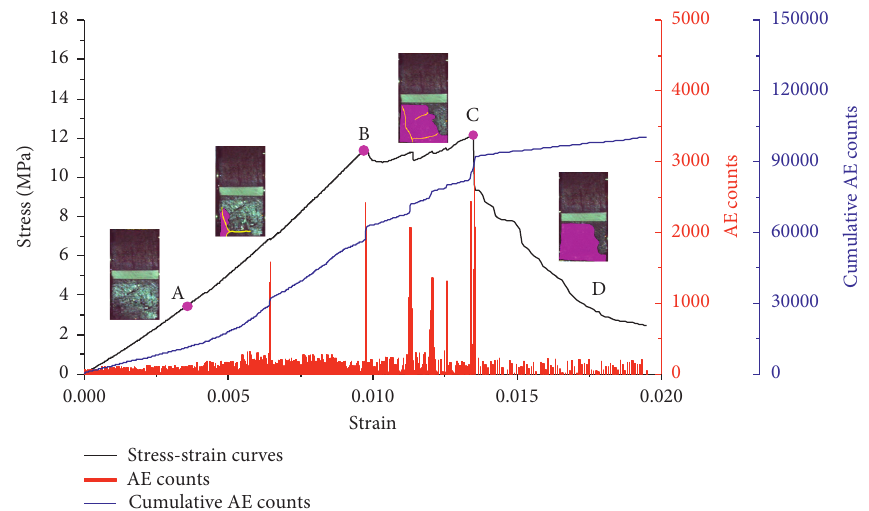
Figure 9: Stress-strain curve and acoustic emission monitoring curve of 10mm-thick composite specimens